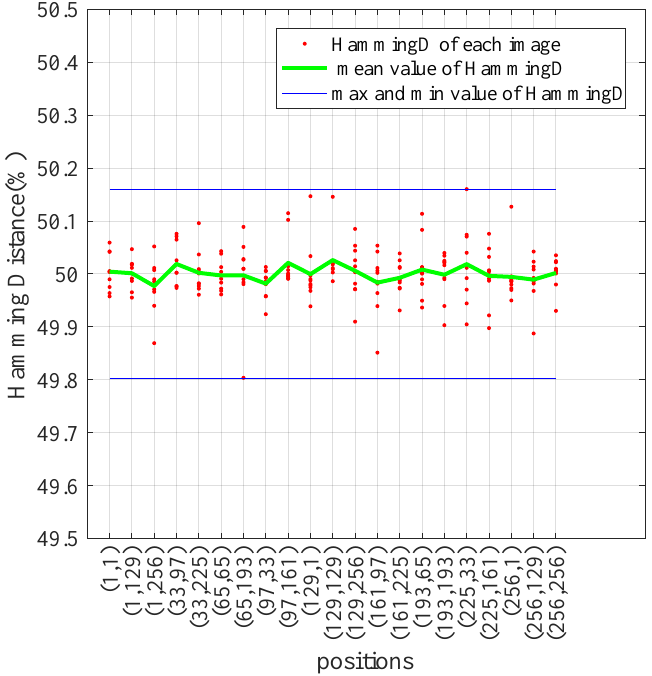
Figure 18. Plaintext sensitivity test evaluated by the Hamming distance.